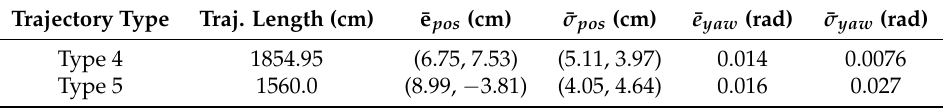
Table 4. Advanced simulation results set 2.